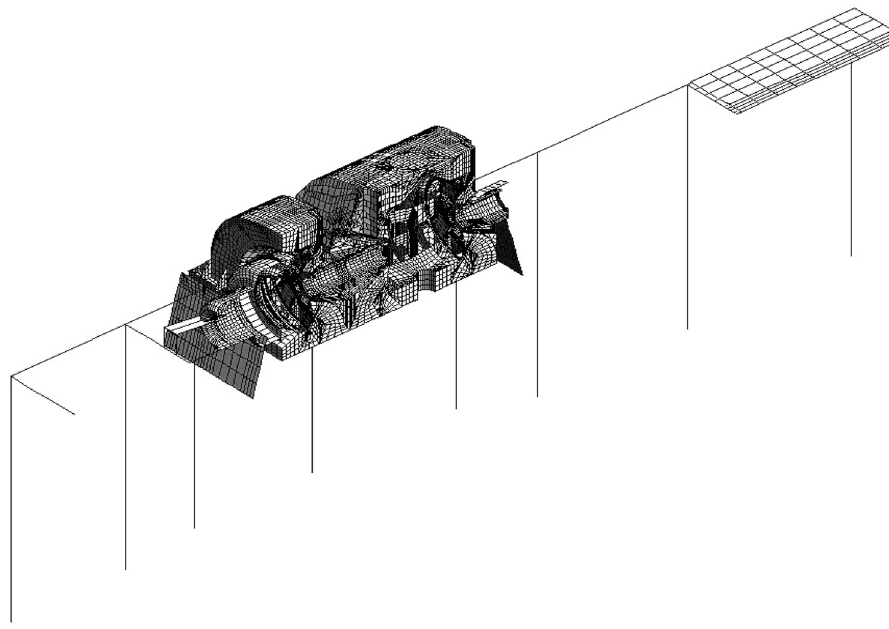
Fig. 4 Computational basic model 11 with a high degree of sampling